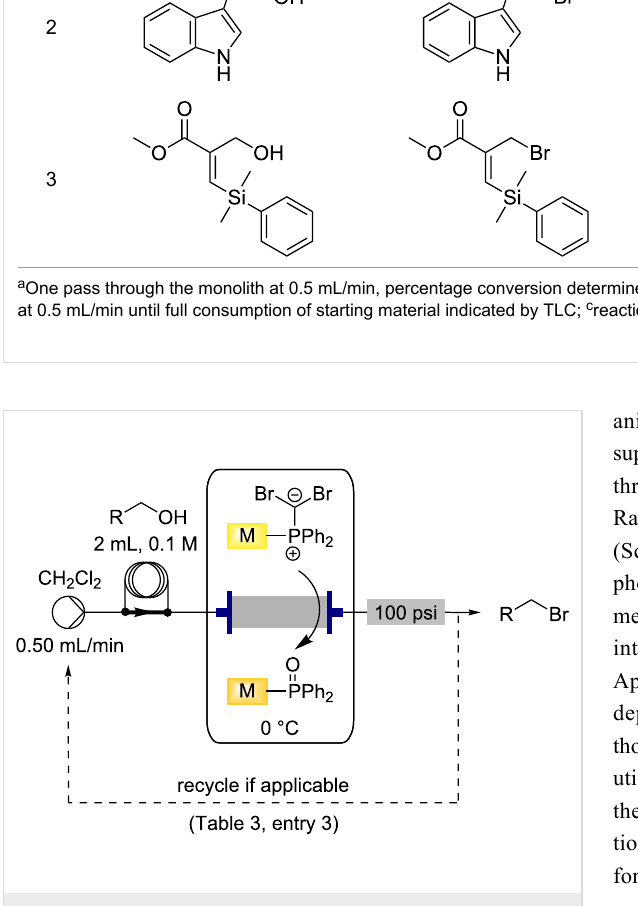
Scheme 5: Flow synthesis of bromides from the corresponding alco- hols using the functionalised triphenylphosphine monolith in the Appel reaction at 0